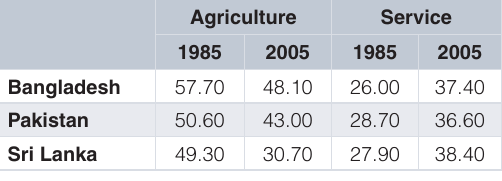
Table 2. Sectoral share of employment in selected South Asian countries (% of total employment).